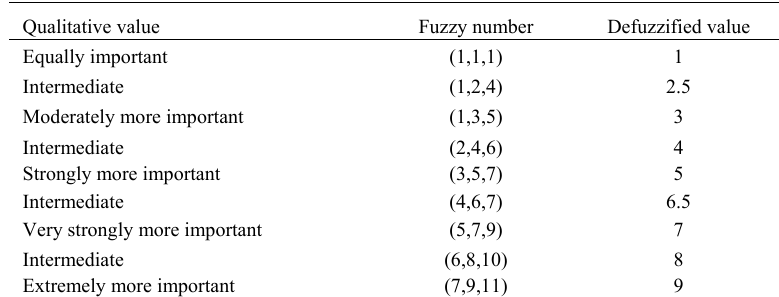
Table 4: Qualitative value and fuzzy scores